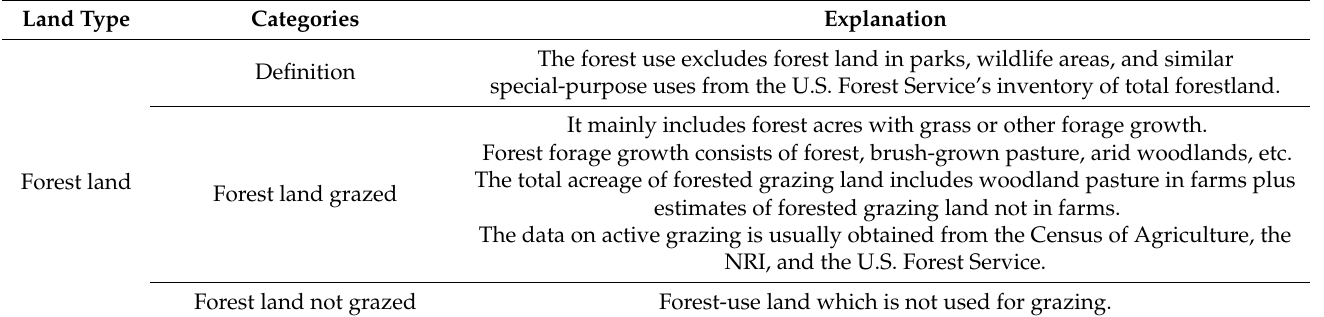
Table 1. Showing the definitions and descriptions of various land types (Source: Bigelow and Borchers,